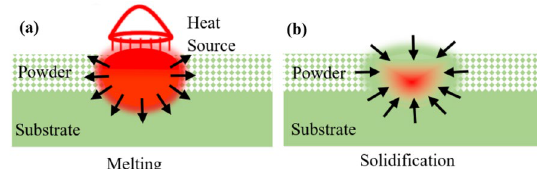
Figure 19 Schematics of residual stress evolution of a melting process and b solidification